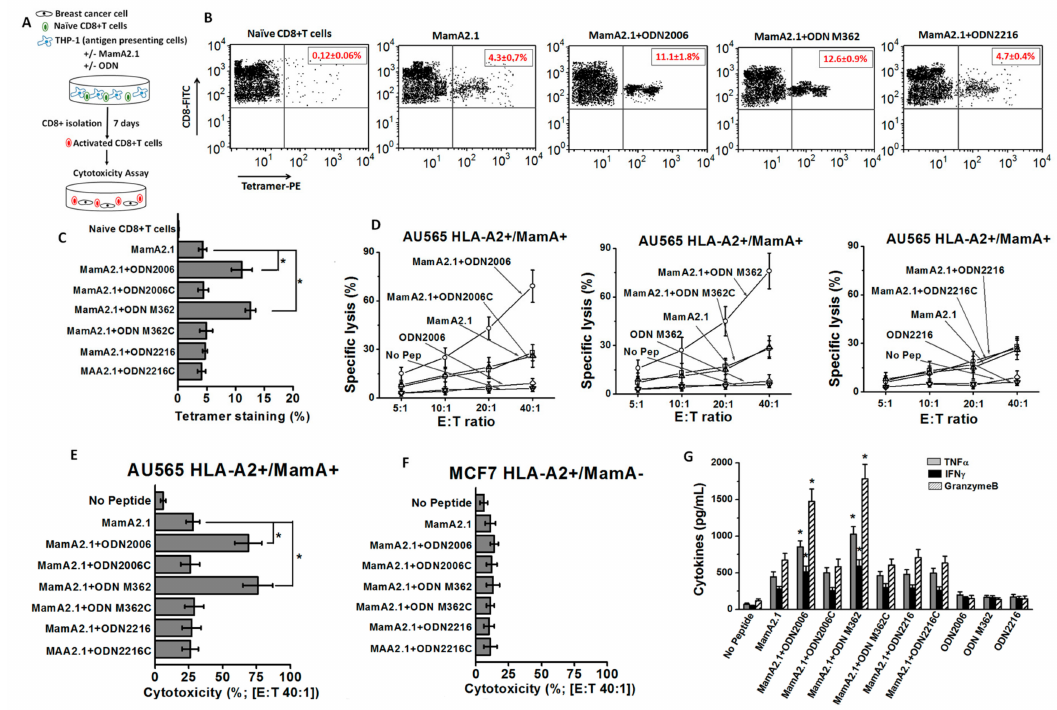
Figure 1. Activation of CD8 + T lymphocytes (CTLs) following antigen presentation by THP1 cells and stimulation by MamA2.1 peptide with and without ODNs. ( A ) Schematic of the experimental design. ( B , C ) MamA2.1 tetramer staining of the CTLs. The naïve CD8 + T cells were stimulated by THP-1 cells pre-treated with either the MamA2.1 peptide alone or in combination with various ODNs. ( D ) Cytotoxicity of CTLs activated under various treatment conditions (mentioned in text) on AU565 breast cancer cells at e ff ector to target (E:T) ratios (from 5:1 to 40:1). ( E , F ) Comparative cytotoxic e ffi ciency of CTLs following various stimulations at E:T ratio 40:1 on AU565 (HLA-A2 + / MamA + ) and MCF7 (HLA-A2 + / MamA − ) breast cancer cell lines. ( G ) Cytokines analyzed from the whole cell lysate of CTLs. All experiments were performed in four independent replicates, and data expressed as mean ± SD, p < 0.05 compared with MamA2.1 peptide treatment alone. MamA: Mammaglobin-A; ODN: